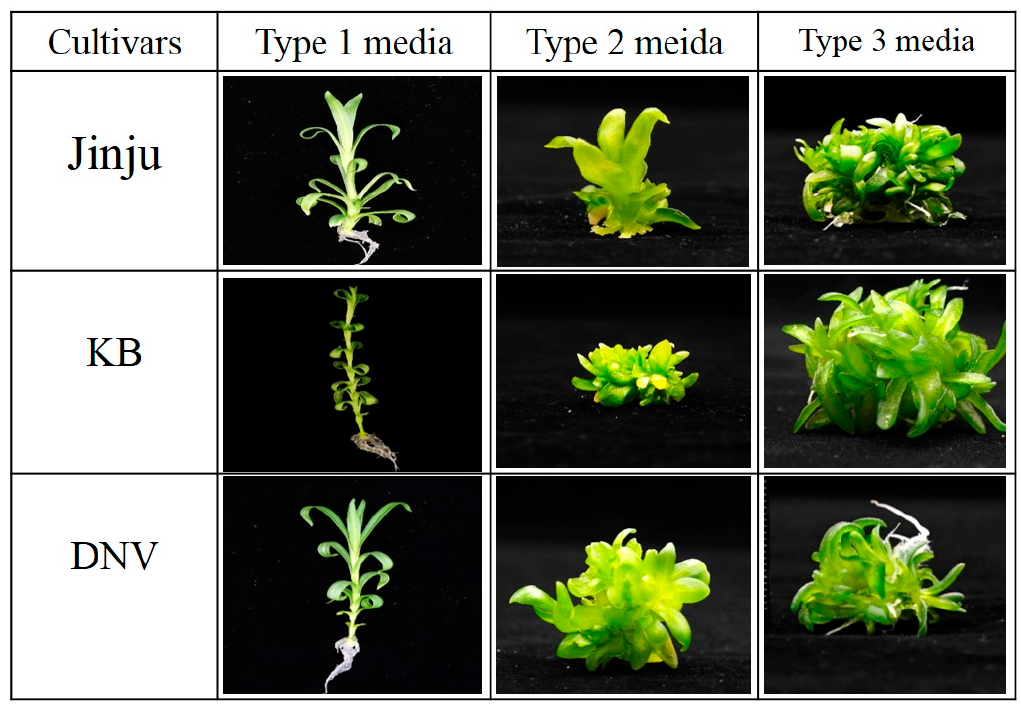
Figure 1. E ff ect of di ff erent types of media on the induction of normal and vitrified shoots in di ff erent Figure 1. Effect of different types of media on the induction of normal and vitrified shoots in different carnation cultivars. carnation cultivars.